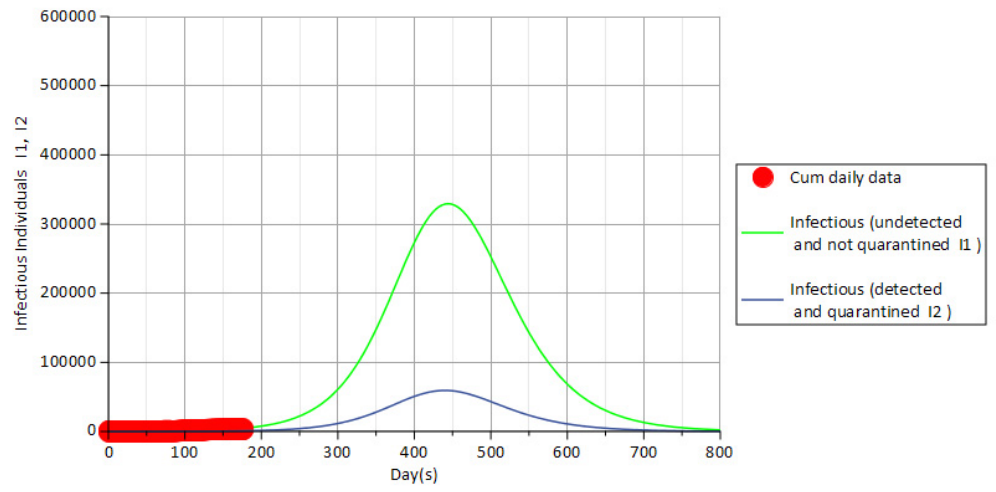
Figure 5. Cumulative daily infectious individuals (red), I 1 ( t ) (green) and I 2 ( t ) (blue) for face masks usage σ f = 0.05 with other parameters as in Table